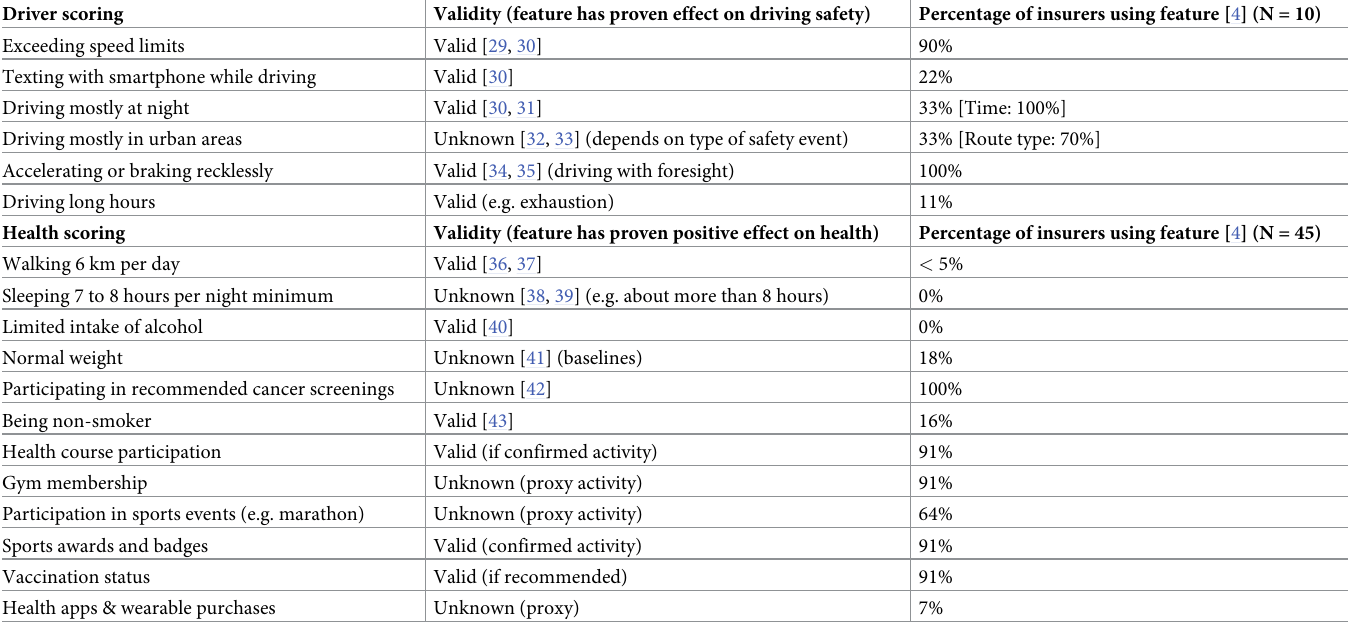
Table 1. Features for driver and health scoring with their validity, and the percentage of insurers using them in Germany. Driver scoring Validity (feature has proven effect on driving